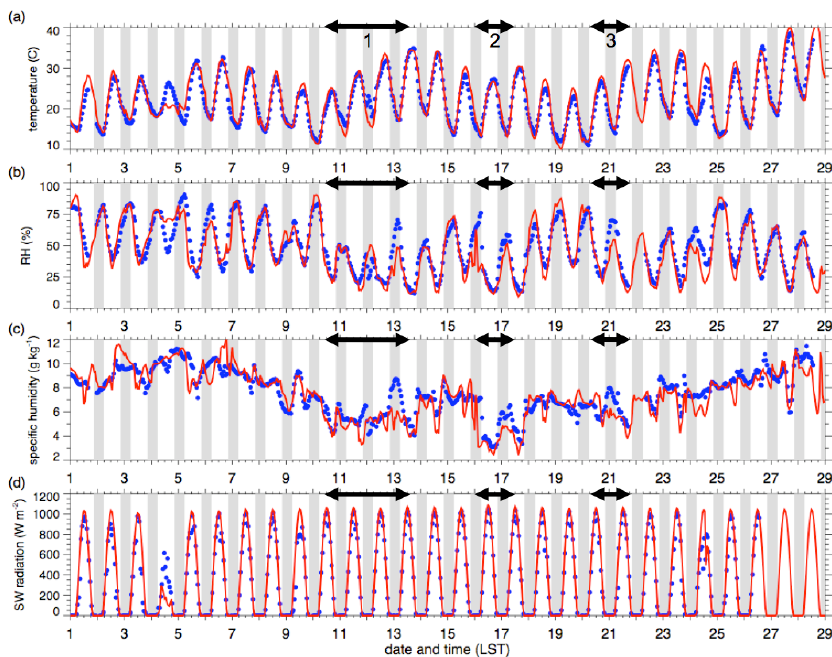
Figure 6. Observed (blue dots) and simulated (red lines) evolution of (a) 2-m temperature, (b) 2-m relative humidity, (c) 2-m specific humidity, and (d) downward shortwave radiation at the T0 site. Gray shading denotes nighttime periods and arrows denote three periods of northwesterly synoptic flow.